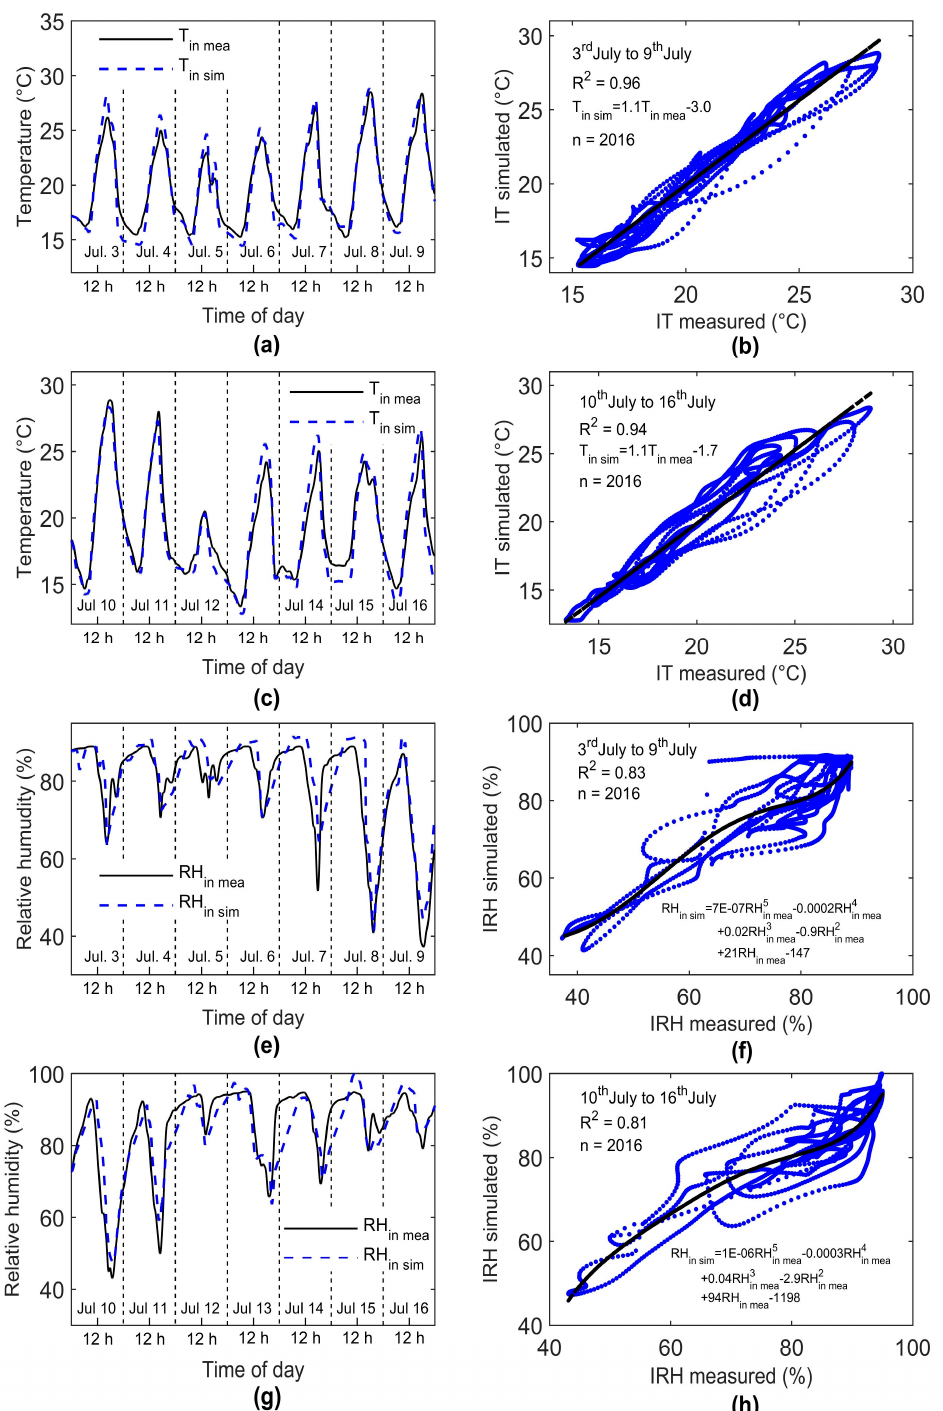
Figure 4. Results of the simulation of the temperature and humidity for two weeks, from 3 July to 9 July and 10 July to 16 July. ( a ) Temperature simulation for the first week . ( b ) Regression analysis for the temperature in the first week, R 2 = 0.94. ( c ) Temperature simulation for the second week. (d) Regression analysis of temperature in the second week, R 2 = 0.92. ( e ) Humidity simulation for the first week. (f) Regression analysis for humidity in the first week, R 2 = 0.83. ( g ) Humidity simulation for the second week. (h) Regression analysis for the humidity in the second week, R 2 = 0.81.